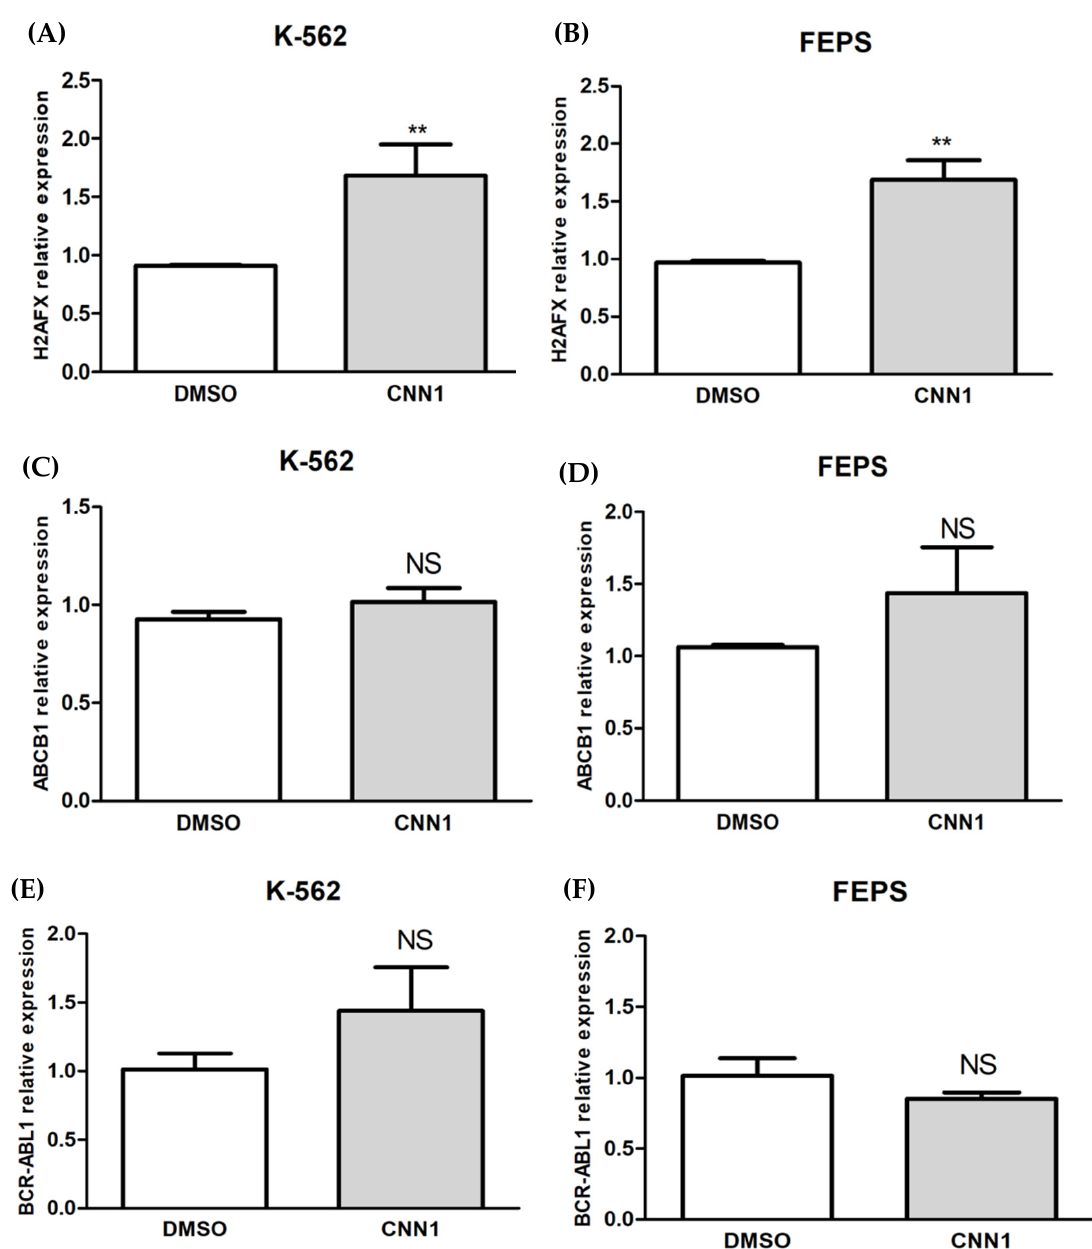
( p > 0.06) in K-562 and FEPS cell lines. The results also showed no significant differences in BCR-ABL1 expression in both K-562 ( p > 0.27) and FEPS ( p > 0.28) cell lines.